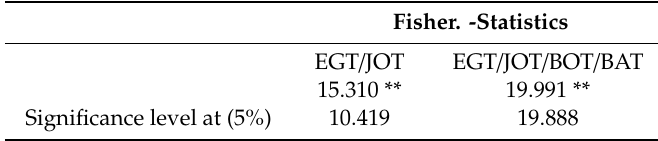
Table 4. Results of the Bayer and Hanck